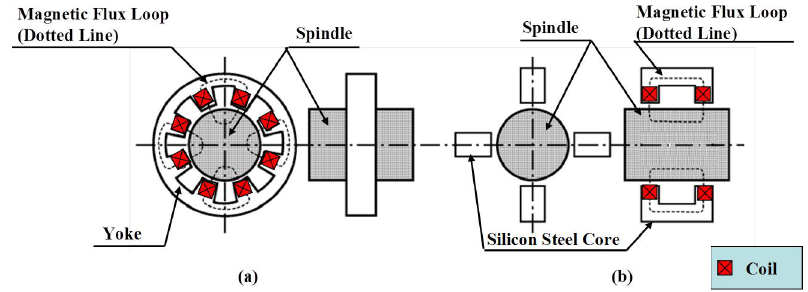
Figure 1. Two configuration types of Active Magnetic Bearing (AMB): ( a ) radial design, and ( b ) modified radial design.